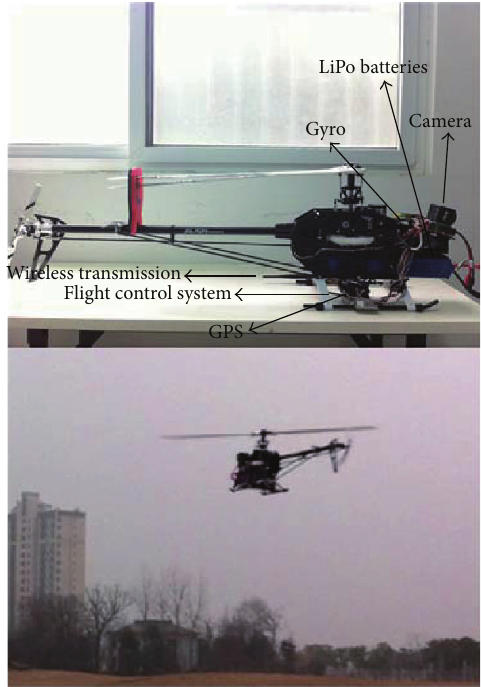
Figure 4: TREX 600 helicopter and flight experiment.